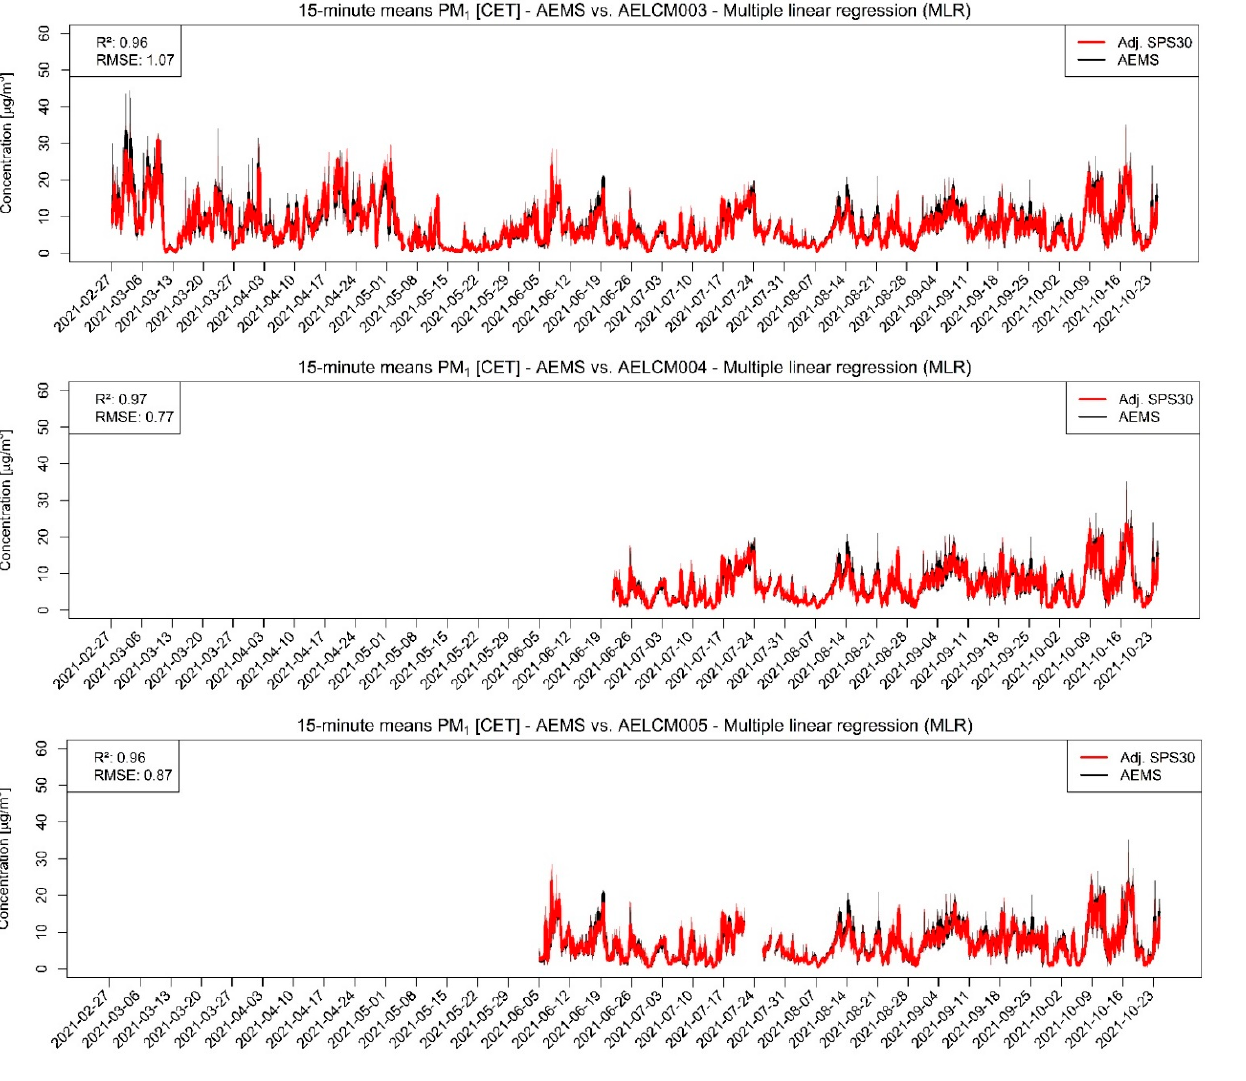
Figure 7. Model-adjusted 15 min concentration means of different deployed SPS30 using multiple linear regression vs. 15 min concentration means of reference measurements given by the AEMS for PM1 in µ g/m 3 . The RMSE is in µ g/m 3 . For smoothing the 15 min concentration means a rolling 24 h average is used: ( Top ) SPS30 deployed in AELCM003; ( Middle ) SPS30 deployed in AELCM004; and ( Bottom ) SPS30 deployed in AELCM005.